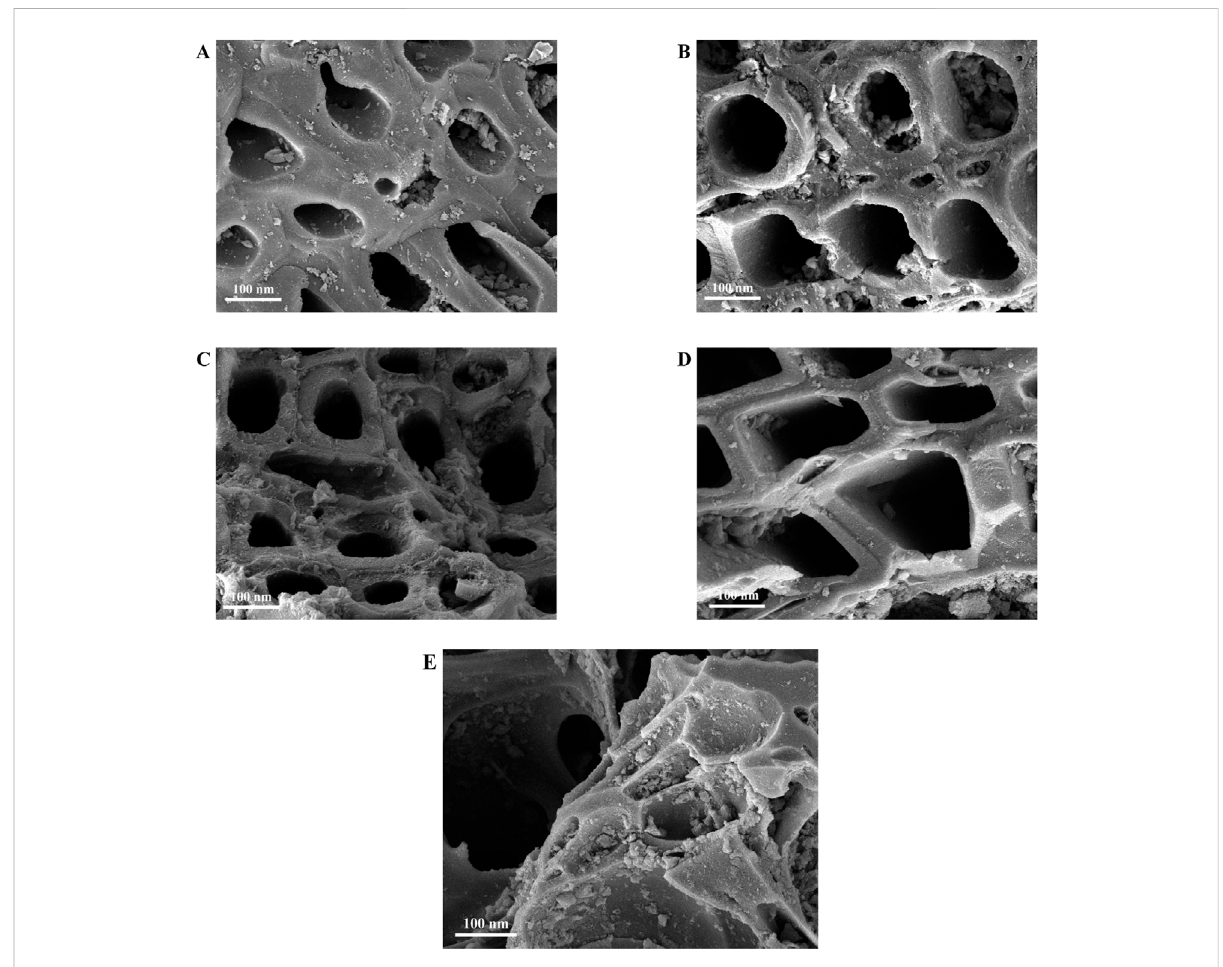
FIGURE 2 SEM images of as-prepared activated carbon samples: (A) NAC-0; (B) NAC-2; (C) NAC-4; (D) NAC-6; (E) NAC-8.